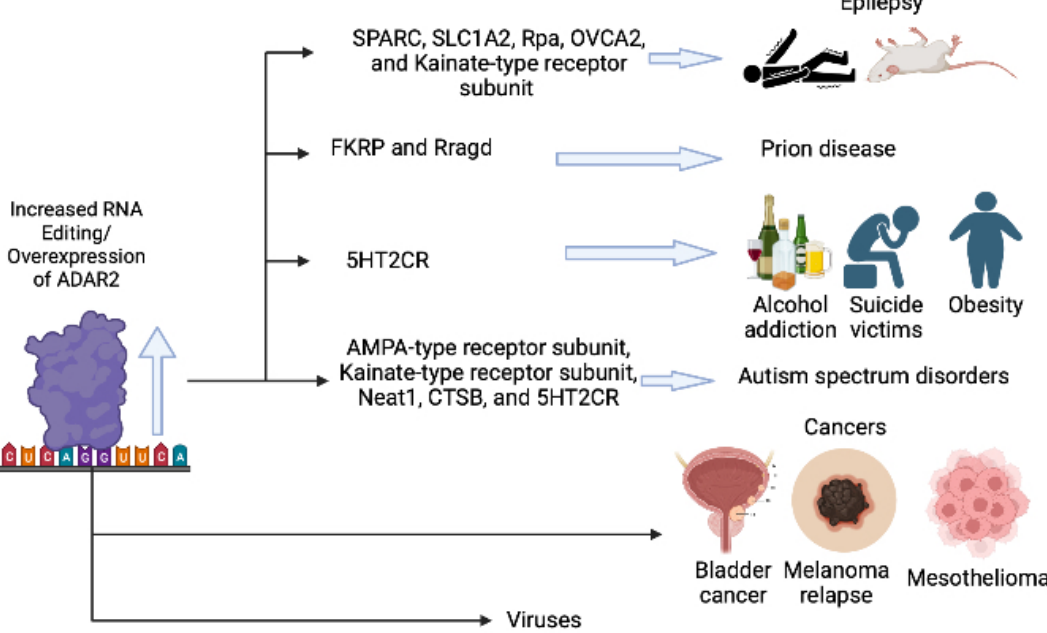
Figure 1. Schema representing the mechanism of ADAR2 overexpression (or increased RNA editing) and the associated diseases. The figure was created using BioRender (https://biorender.com/ accessed on 30 March 2023).